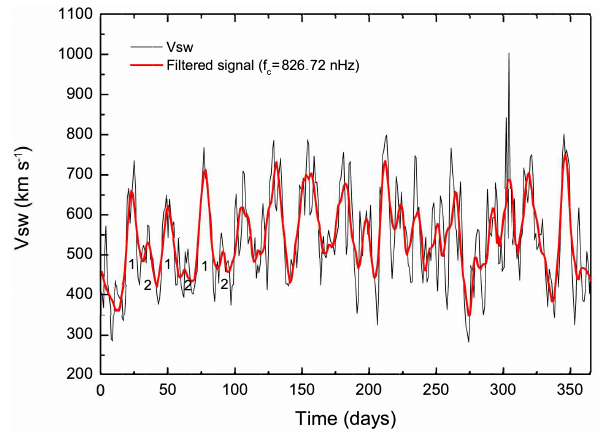
Figure 3. Daily time series of solar wind speed for 2003 (black line) and low-pass filter with a cutoff frequency ( f c ) of 826.72nHz (red